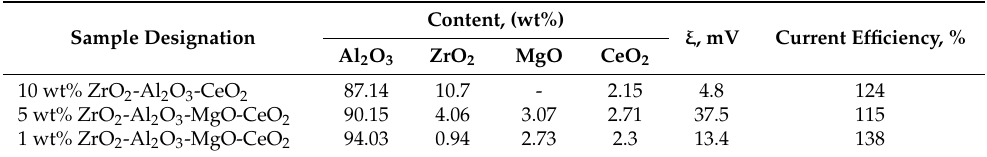
Table 1. Grade and composition of Al 2 O 3 -ZrO 2 .